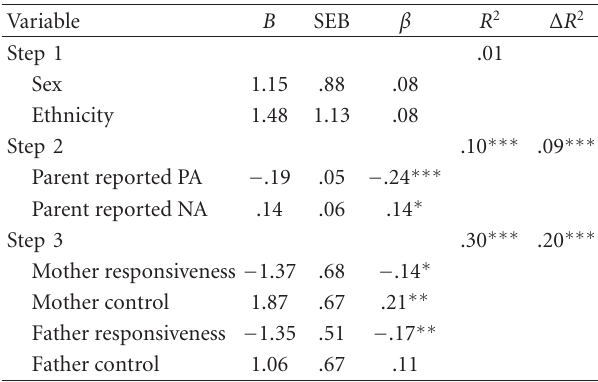
Table 4: E ff ect of mother and father responsiveness and psycholog- ical control in predicting child mood after controlling sex, ethnicity, and parent-reported child positive and negative a ff ect ( N = 268).